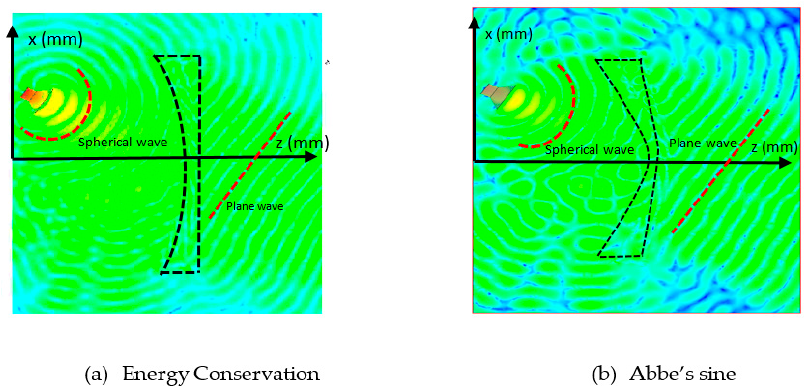
Figure 21. Electric field distribution during off-focus.